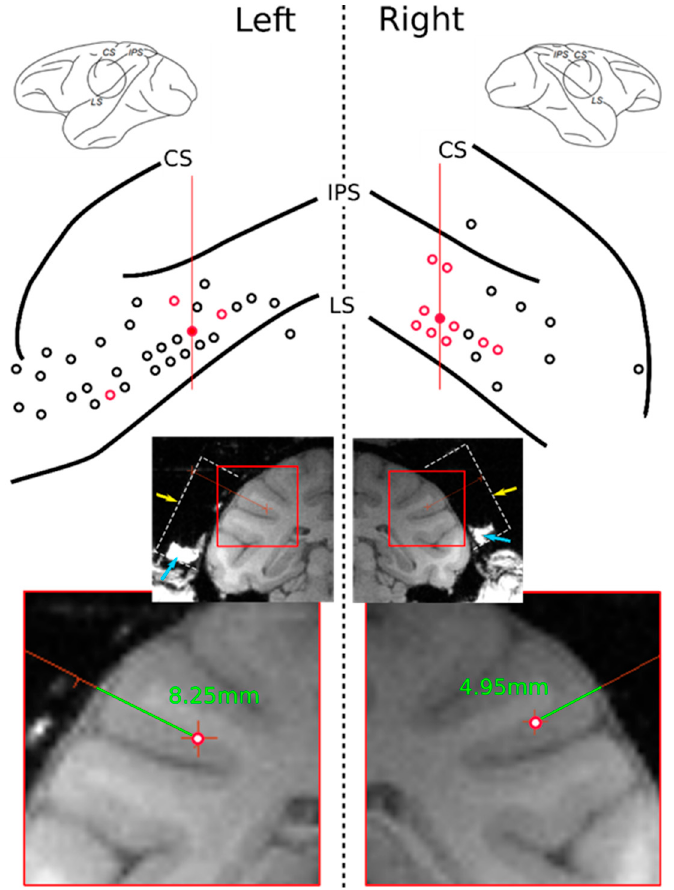
Figure 2. Upper: Electrode penetration sites (red and black circles) on the surfaces of the left and right hemispheres. Red circles indicate locations where self-related mirror responsive neurons were found. Central, intraparietal, and lateral sulci indicated as CS, IPS, and LS, respectively. Red lines indicate the position of the MRI slices shown below. Lower: Coronal MRI slices of the recorded subject show the recording chamber’s location (dashed white line, reconstructed). Yellow arrow points to the top of the chamber where the recoding grid was positioned. Blue arrows indicate tissue and liquid naturally accumulated within the bottom walls of the chamber. A cropped detail below shows reconstructed electrode tracks (green lines) of two examples of mirror responsive neurons found in the red-filled tracks on the upper drawing with their respective depths of